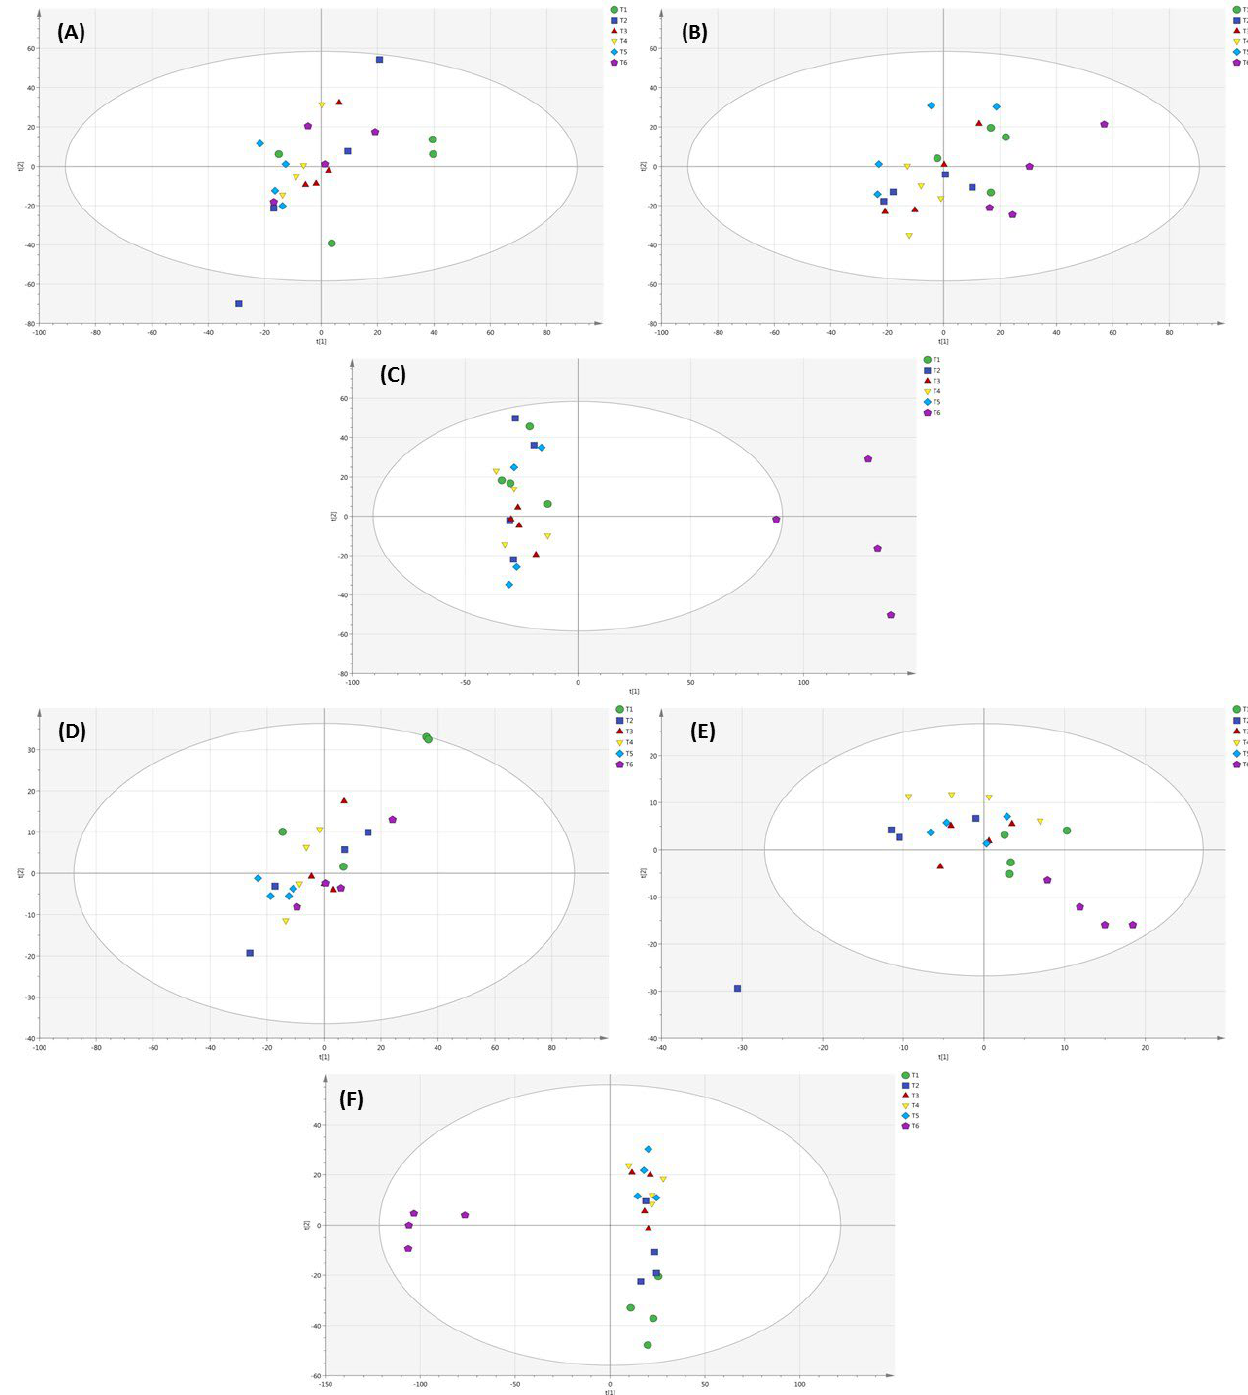
Figure 8. PCA and PLS-DA analysis of the metabolomic profile of lettuce with different applied NH 4+ /NO 3 − ratios (100:0, 75:25, 50:50, 25:75 and 0:100%) and control (no additional N applied) in soil, substrate and hydroponic cultivation systems by UPLC VION IMS QTOF-MS/MS analysis. Note- ( A – C ) represents PCA analysis and ( D – F ) represents PLS-DA analysis of metabolomic profiling of let- tuce in soil, substrate and hydroponic cultivation system by UPLC VION IMS QTOF-MS/MS analysis. Green color represents NH 4 + /NO 3 − (100/0%), blue color represents NH 4 + /NO 3 − (75/25%), red color represents NH 4 + /NO 3 − (50/50%), yellow color represents NH 4 + /NO 3 − (25/75%), sky-blue color represents NH 4 + /NO 3 − (0/100%) and purple color represents